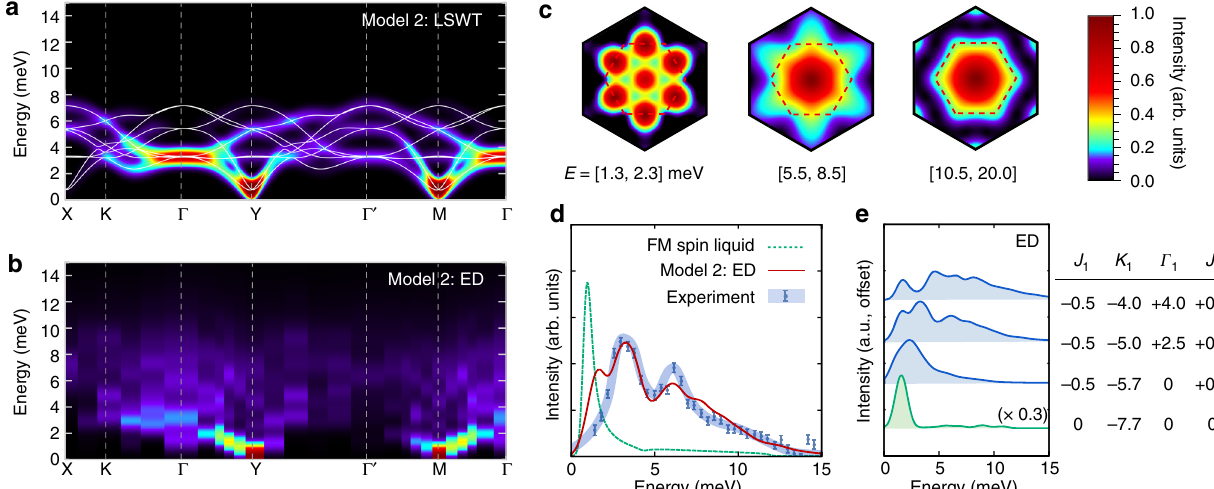
Fig. 3 Neutron scattering intensity Ið k ; ω Þ within the extended model. a – c Detailed results for Model 2 ( J 1 = − 0.5, K 1 = − 5.0, Γ 1 = +2.5, J 3 = +0.5 meV): a Ið k ; ω Þ computed via LSWT; results are averaged over the three zigzag domains with ordering wavectors parallel to the X-bonds, Y-bonds, and Z-bonds. b ED results, combining data from several 20-site and 24-site periodic clusters (see “ Methods ” ). c ED k -dependence of Ið k ; ω Þ integrated over the indicated energies, as obtained from a single 24-site cluster respecting all symmetries of Eq. (1) (see “ Methods ” ). d Comparison of Γ -point intensities for the K 1 = 12 . e Evolution of the ED Γ -point intensity with − 7.7 meV FM spin liquid (exact results 53, 54 ), Model 2 (ED), and the experimental data for α -RuCl 3 decreasing Γ 1 = K 1 j j , showing signi fi cant broadening at fi nite Γ 1 . The top three interaction sets correspond to zigzag order, while the bottom is the K 1 < 0 spin liquid. For all spectra, a Gaussian broadening of 0.5 meV has been applied